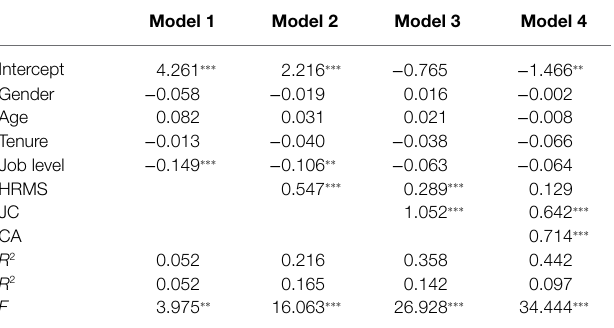
TABLE 3 | The mediating effect